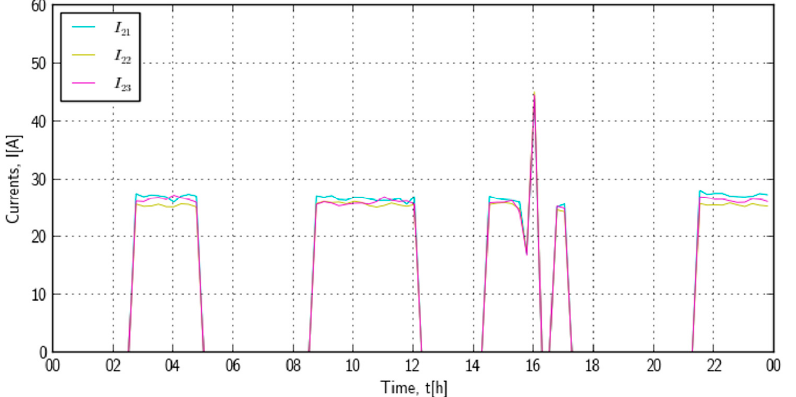
Figure 21. The diagrams of the load current changes of the PU2 recorded on 21 June 2009. (Sampling period of 15 min).